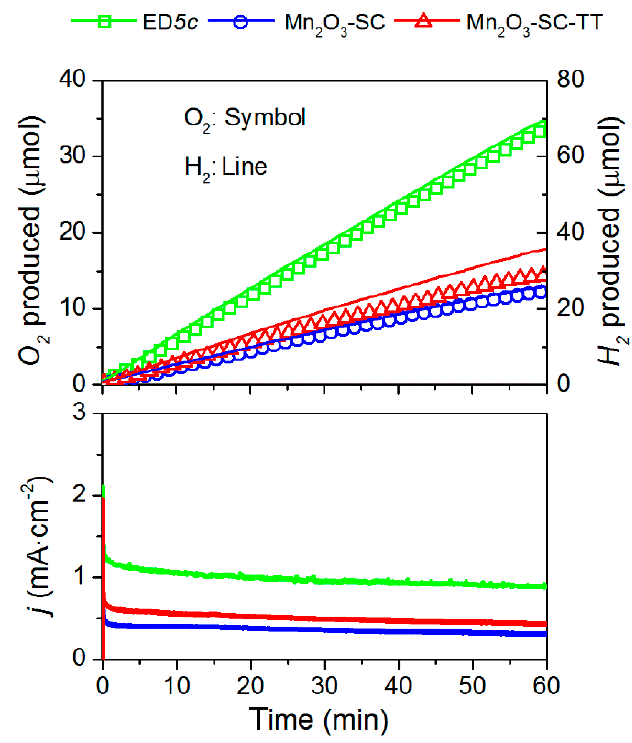
Figure 6. Oxygen and hydrogen evolutions under an applied potential of 2.0 V vs. RHE. Time course of the O 2 and H 2 production analyzed by a micro-GC ( up ) and of the measured current densities ( bottom ).